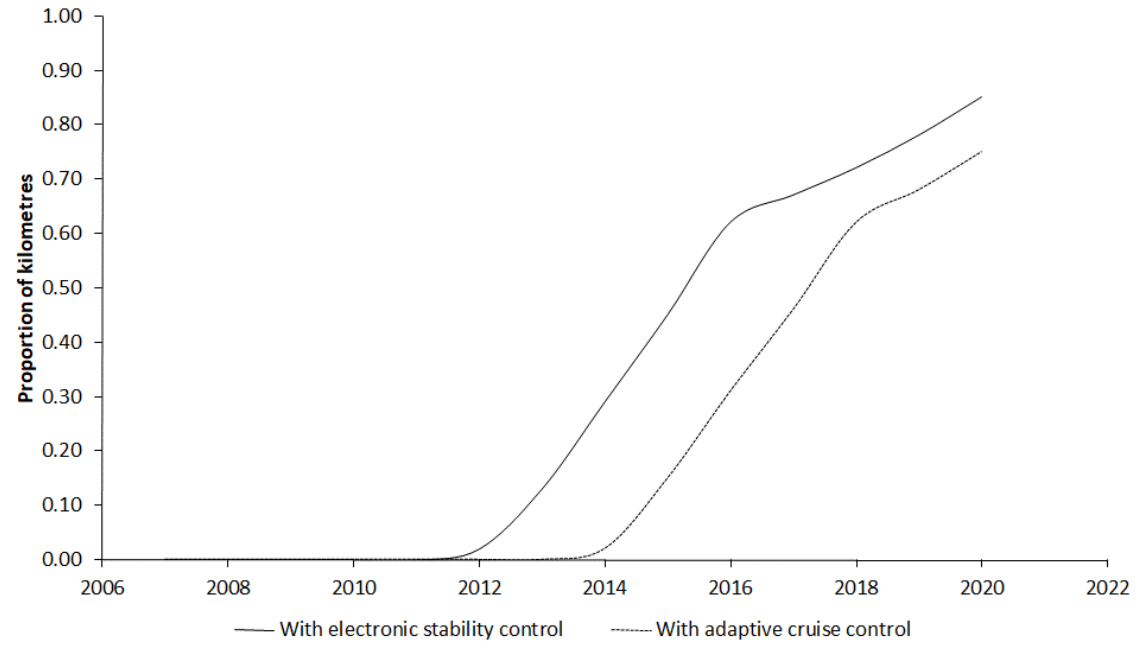
Figure 2 Share of kilometres by cars with electronic stability control and adaptive cruise